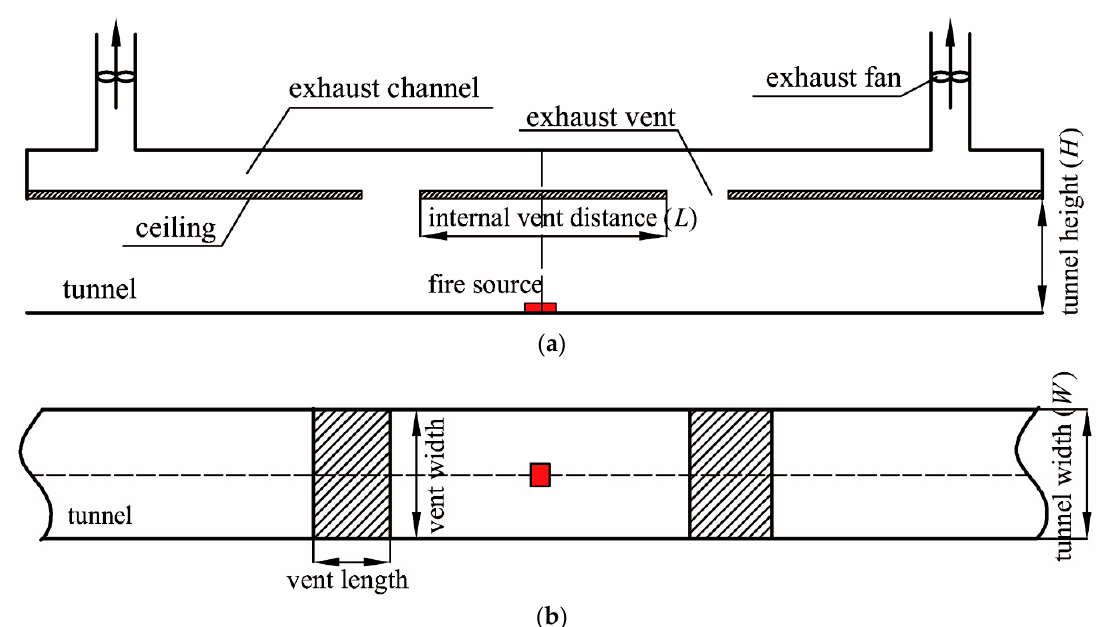
Figure 11. The schematic layout of physical model ( a ) front view, ( b ) top view.